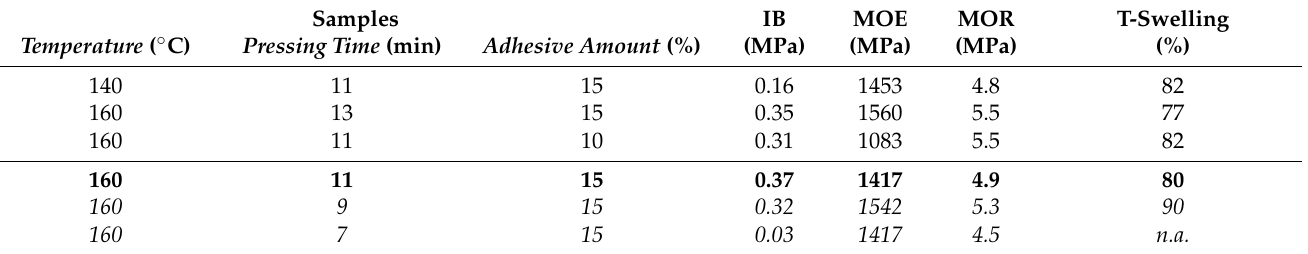
Table 3. Physical and mechanical outcomes from the optimization of process parameters at 160 ◦